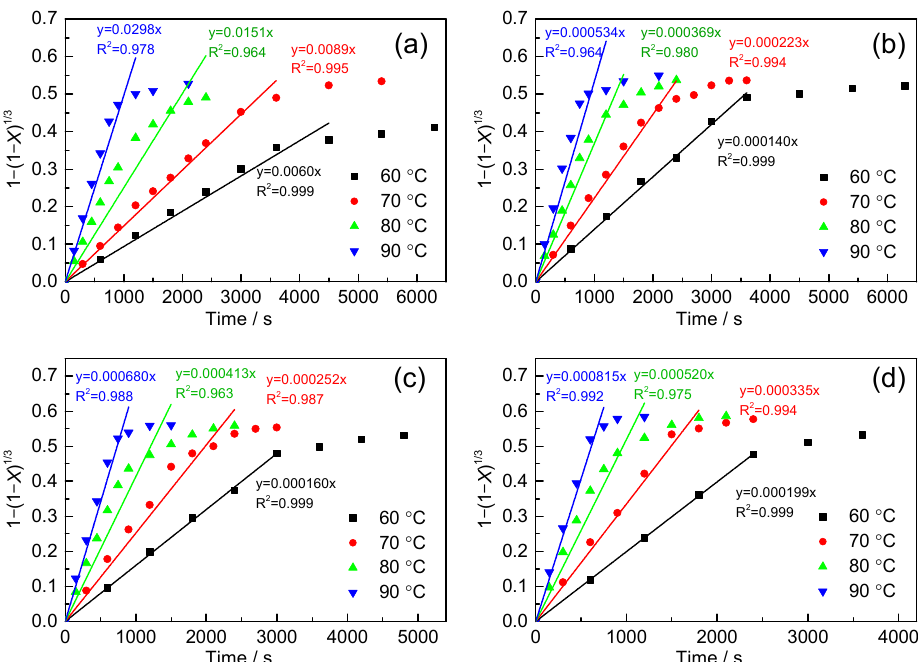
Figure 7. Plots of 1 − (1 − X ) 1/3 versus time for different leaching temperatures with L / S ratio of 20:1 and rotating speed of 200 r/min. ( a ) C F - = 8 mol/L; ( b ) C F - = 10 mol/L; ( c ) C F - = 12 mol/L; ( d ) C F - = 14 mol/L.